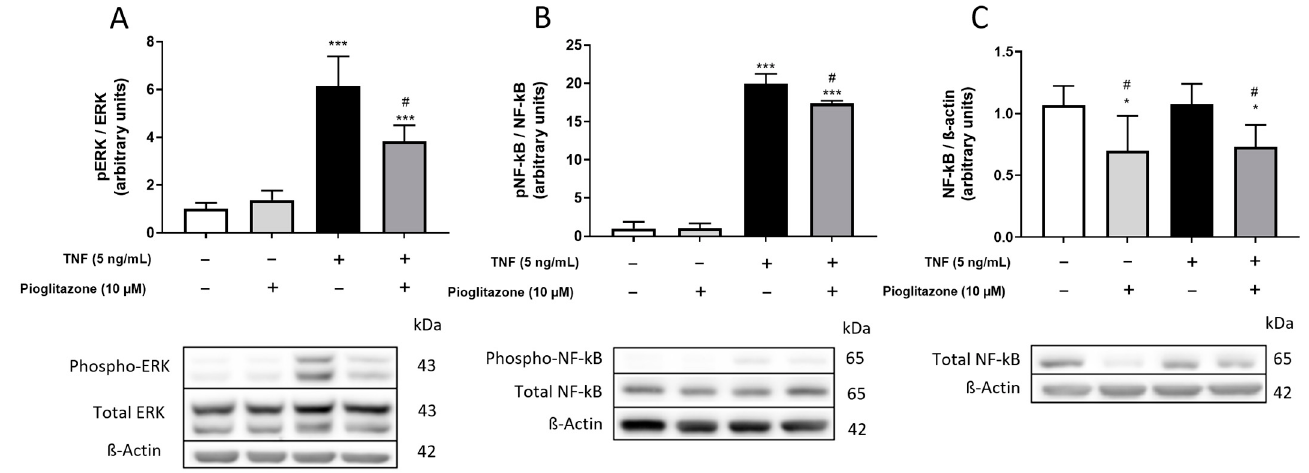
Figure 6. Effects of pioglitazone on TNF α -induced phosphorylation of ERK and NF-kB. BLECs were treated with 5 ng/mL of TNF α for 30 min following pre-treatment with 10 µM pioglitazone for 24 h; phosphorylation of ERK and NF-kB was assessed by Western blotting ( A , B ). Endothelial cells were also treated with 5 ng/mL of TNF α for 24 h rather than 30 min following pre-treatment with 10 µM pioglitazone for 24 h; expression of total NF-kB was assessed by Western blotting ( C ). Results are shown as mean ± standard deviation (n = 4) and were analyzed via one-way ANOVA followed by Tukey’s post hoc test. Representative bands are aligned with treatment order as denoted below graphs. *, *** p < 0.05 and 0.01 in comparison to control groups; # p < 0.05 in comparison to TNF α -treated group.